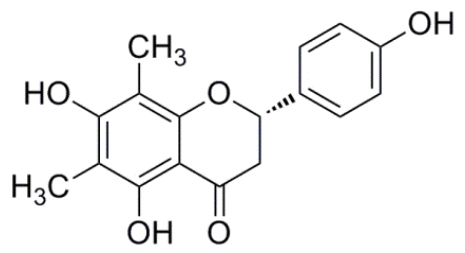
Figure 7. Chemical structure of